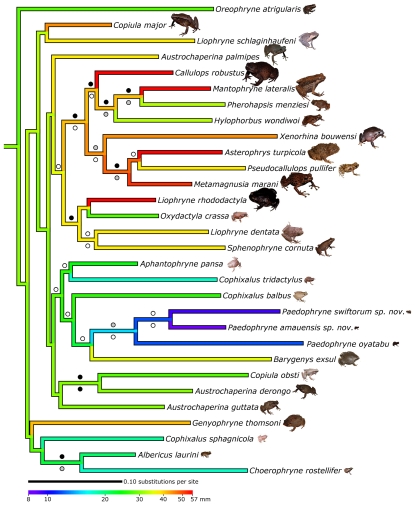
Phylogenetic position of Paedophryne and evolution of body size in Asterophryinae.Maximum likelihood phylogeny of Paedophryne and asterophryine frogs. Colors of branches correspond to maximum male SVL (Paedophryne) or average SVL within each clade on a logarithmic scale (Table 6). Circles above branches correspond to posterior probabilities: black: >0.95; grey: 0.85–0.95; white: 0.5–0.85. Circles below branches correspond to maximum likelihood bootstrap support: black: >95%; grey: 75–95%; white: 50–75%.